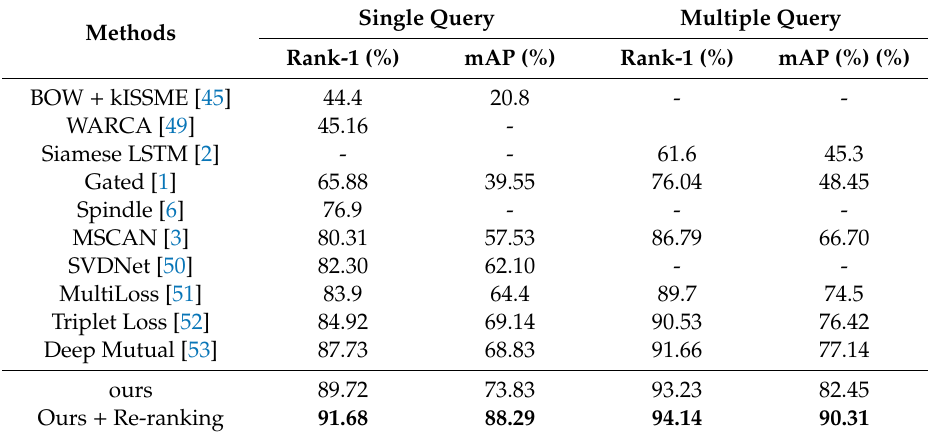
Table 5. Single query and multiple query comparisons on the Market-1501 dataset.